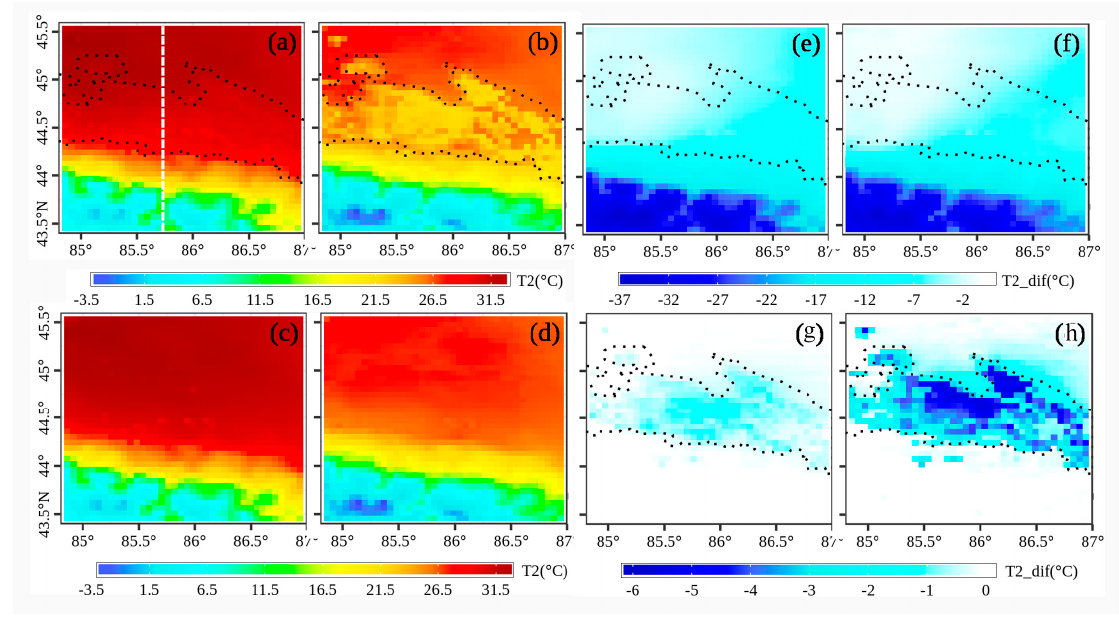
Figure 6. Mean 2-m air temperatures (T2) from the ( a , b ) mod simulation and ( c , d ) the non-oasis simulation; ( e , f ) and the differences between the mod simulation and non-mountain simulation; and ( g , h ) the differences between the mod simulation and the non-oasis simulation during daytime and nighttime, respectively. The black dotted line represents the border of the oasis and the white dotted line ( a ) represents the location of the vertical section (longitude 85.7° E) represented in Figure 7.